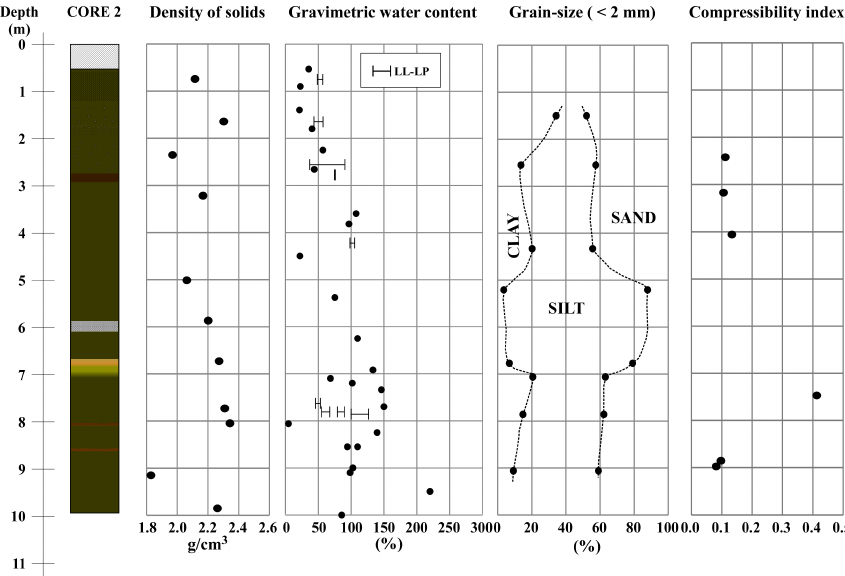
Figure 5. Core two and some of its geotechnical properties. LL-LP represents the values of liquid and plastic Atteberg